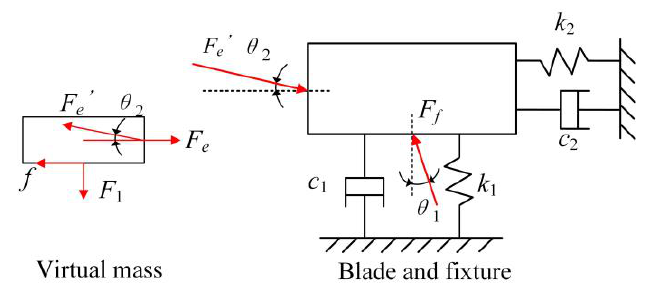
Figure 11. Schematic diagram of test structure.